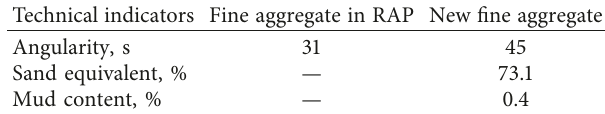
the Grunberg Nissan equation to compound the viscosity of regenerated asphalt. The model equation is shown in equation (5) [36].